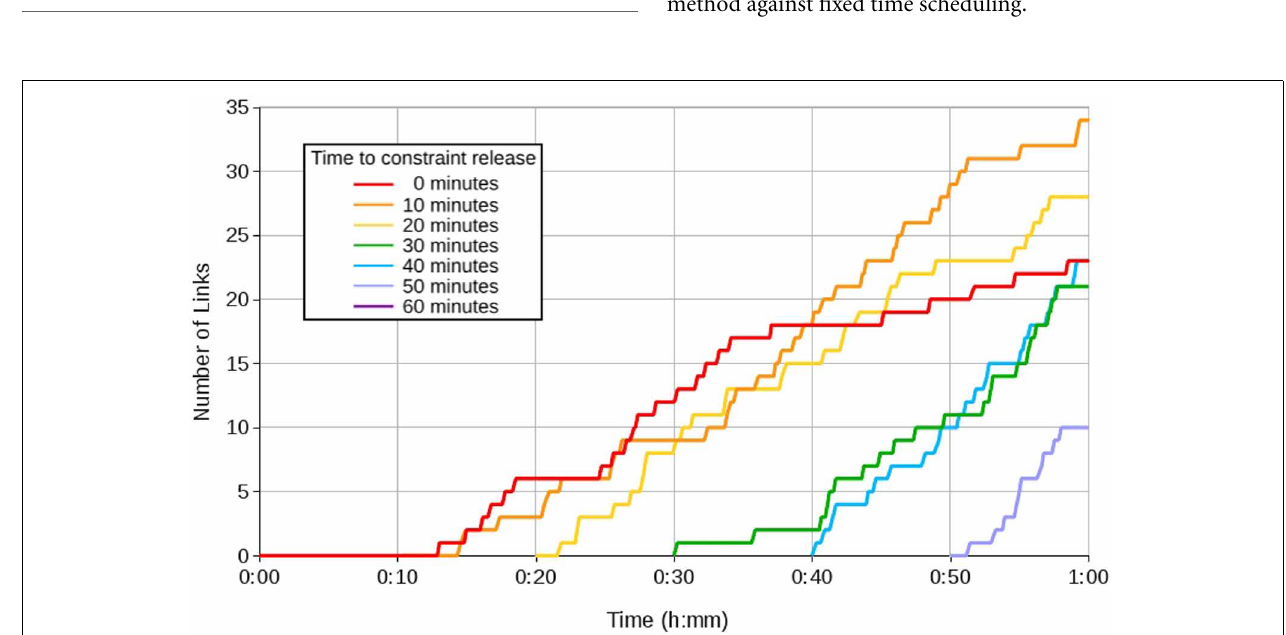
FIGURE 6 | Graph showing head learning with a Type A constraint lifted at 10min